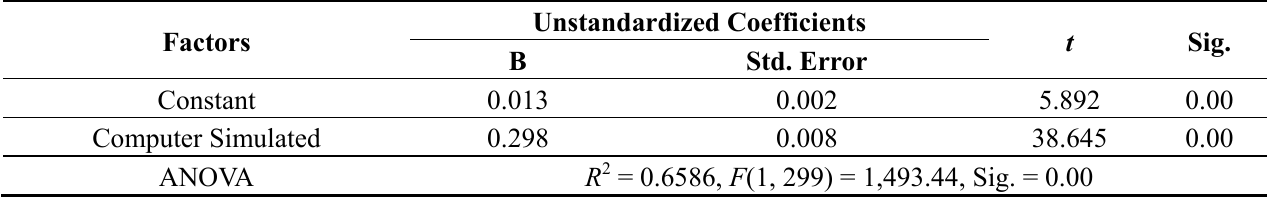
Table 4. Linear relationship of Δ Temperature between computer simulation and ANN